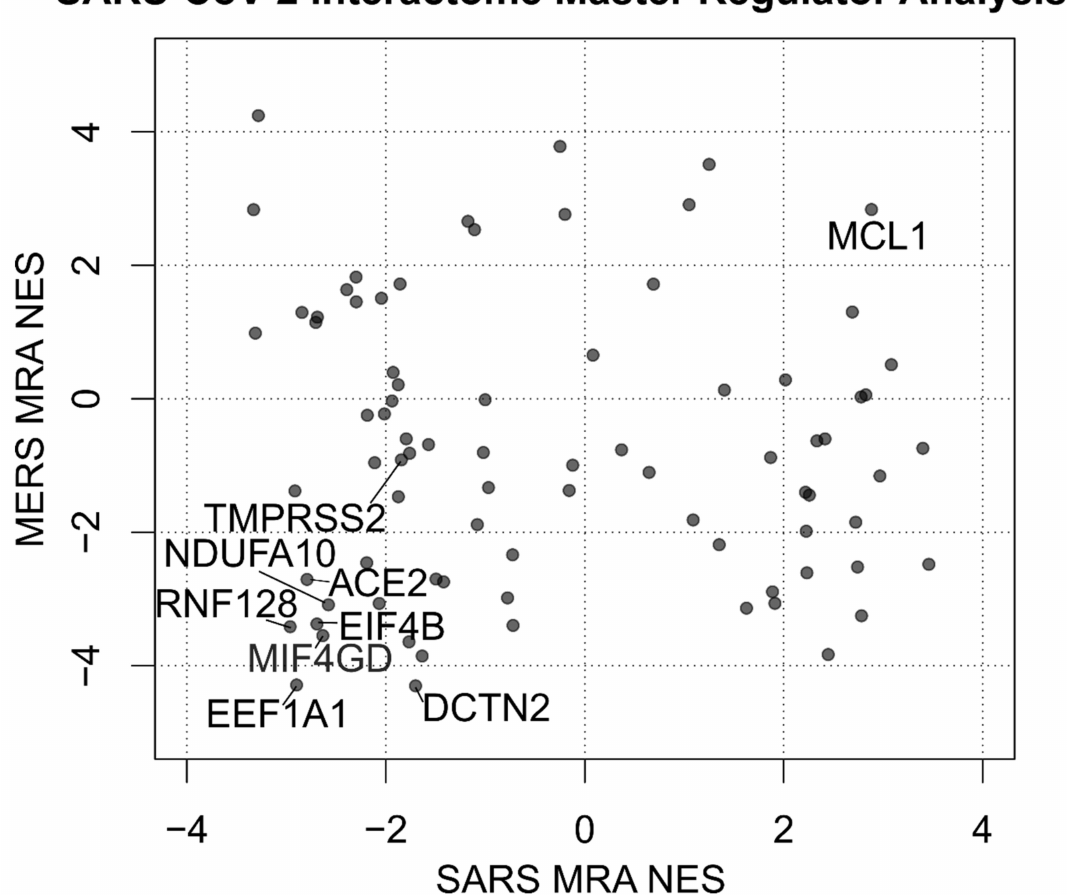
Figure 3. Scatterplot depicting the Normalized Enrichment Scores (NES) of the Master Regulator Analysis of human proteins interacting with SARS-CoV-2. Two analyses are compared using the signatures of MERS and SARS infection on human bronchial 2B4 cells. TMPRSS2, along with the 8 most significant proteins by absolute sum of NES, is labeled. Full results are available in Supplementary Table